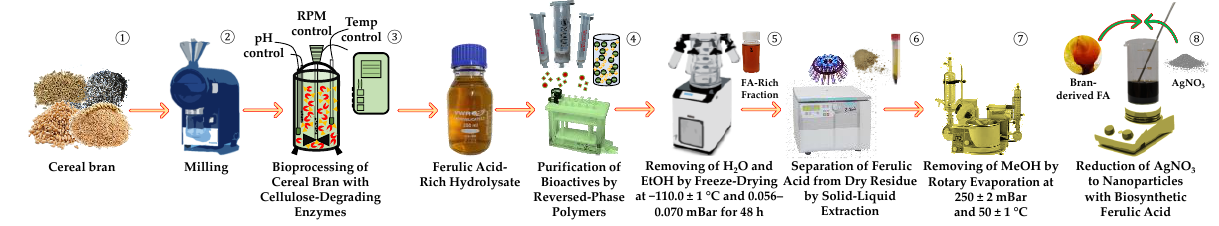
Figure 1. A schematic representation of major sample preparation steps undertaken for isolation of trans -FA and trans - iso -FA from rye bran for further green synthesis of silver nanoparticles. In a separate trial, the effect of the capping agent was clarified by the addition of 80 mg amphiphilic polyvinylpyrrolidone (PVP-40) agent to the mixture of AgNO 3 and reducing compound while keeping the same proportions.